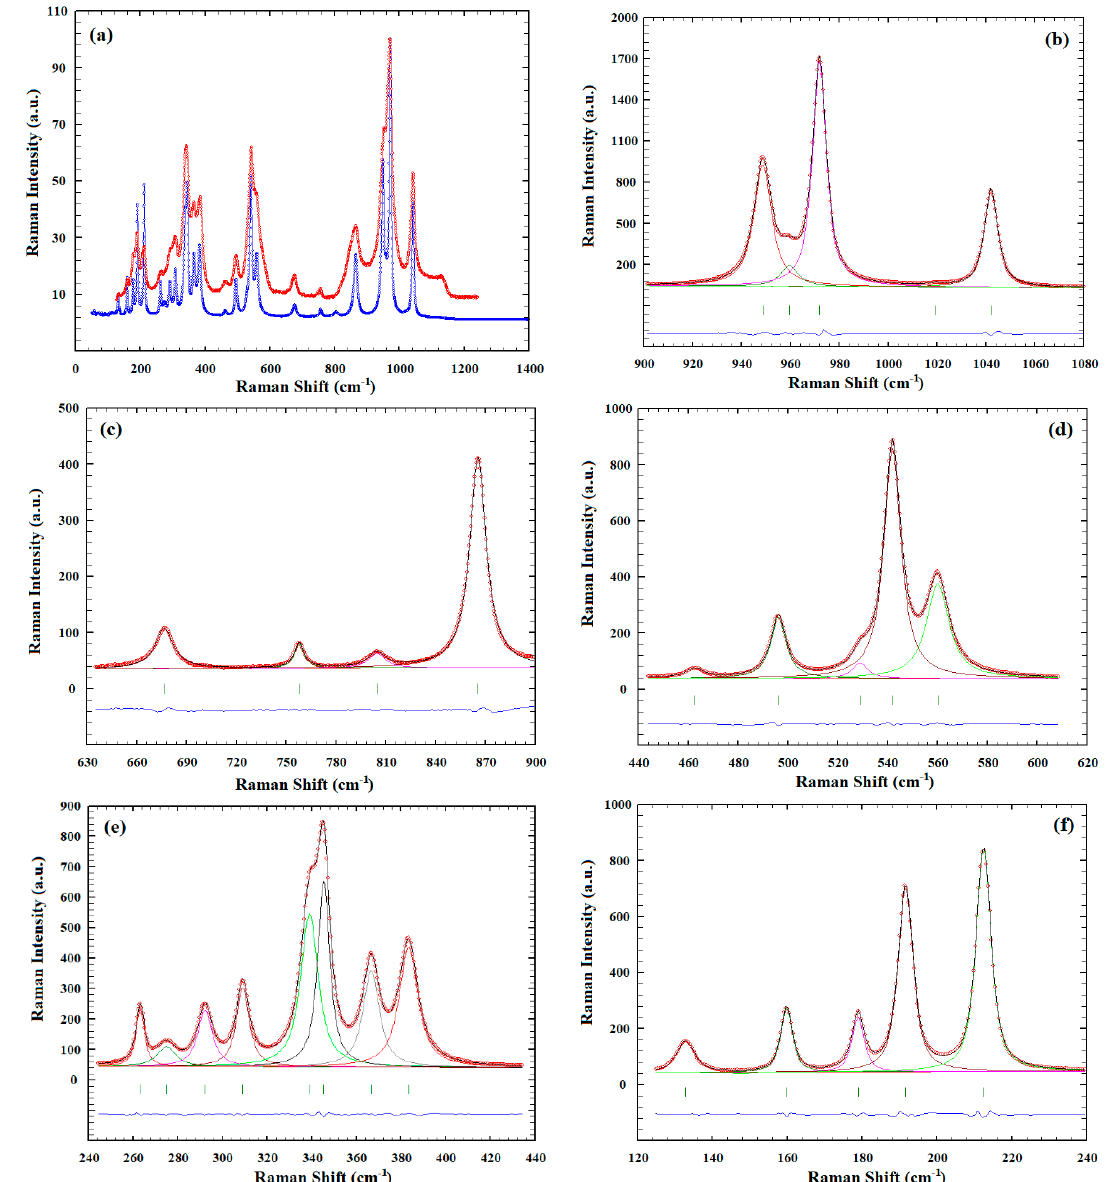
Figure A5. ( a ) Comparison of the Raman spectrum of the 900 °C sintered sample (blue) with the one of a natural aegirine sample as given in the RUFF data-base (red) and ( b – f ) representative peak fittings in regions R1–R5 for the 900 °C sample.